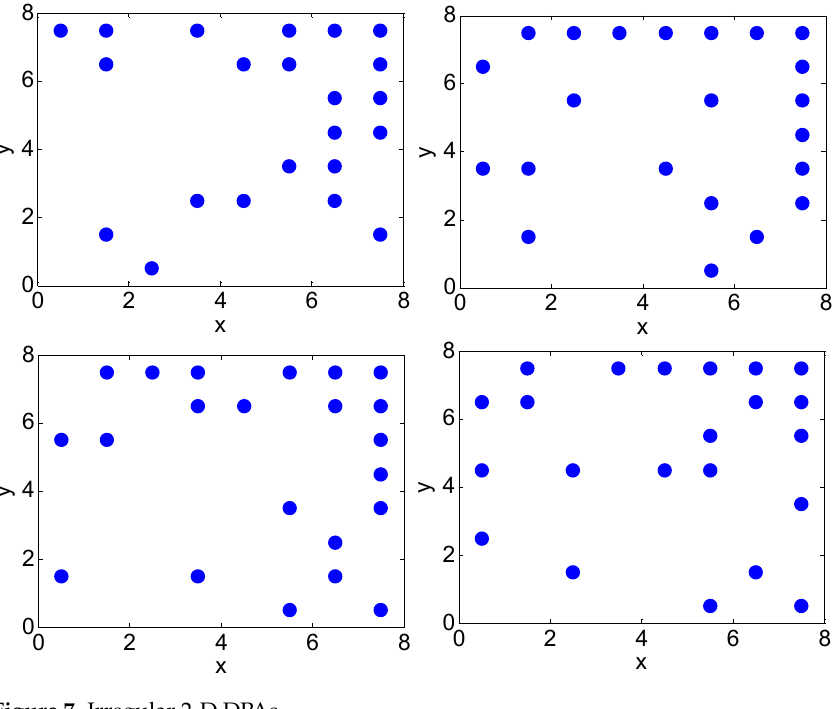
Figure 7. Irregular 2-D DPAs.